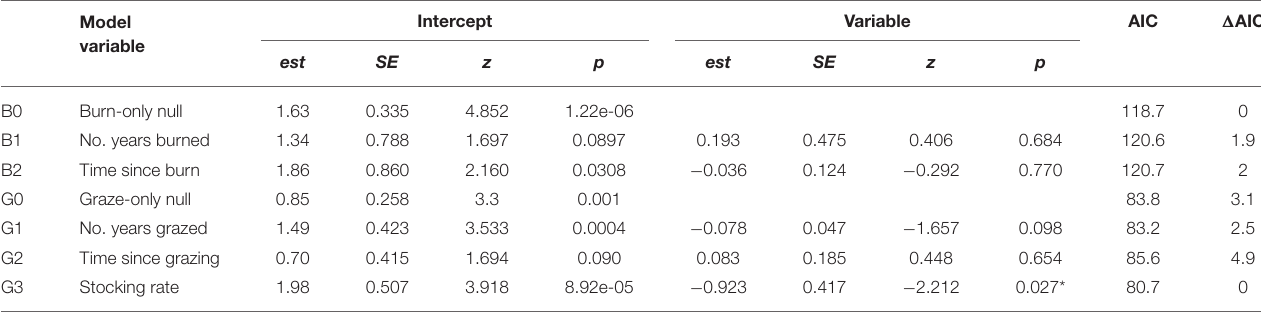
TABLE 4 | Univariate models showing the effects of fire- (B0 – B2) and grazing- (G0 – G3) specific predictor variables on monarch abundance at burned or grazed sites, respectively. Model variable